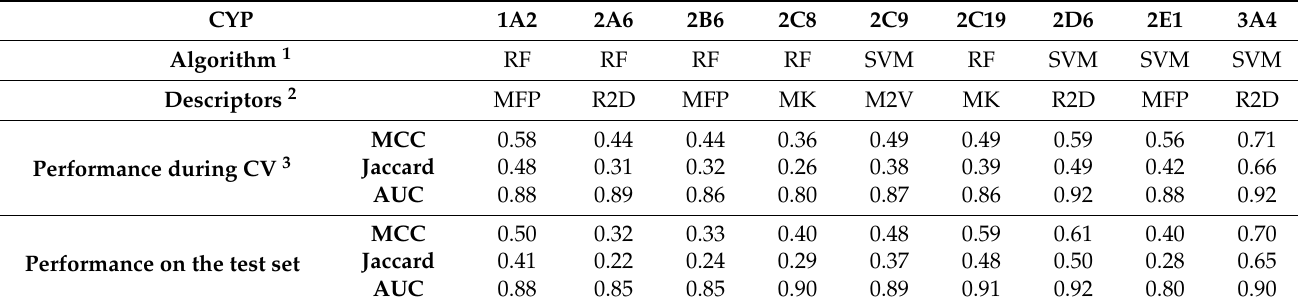
Table 2. Performance of the best-performing classifiers by MCC built on a single feature